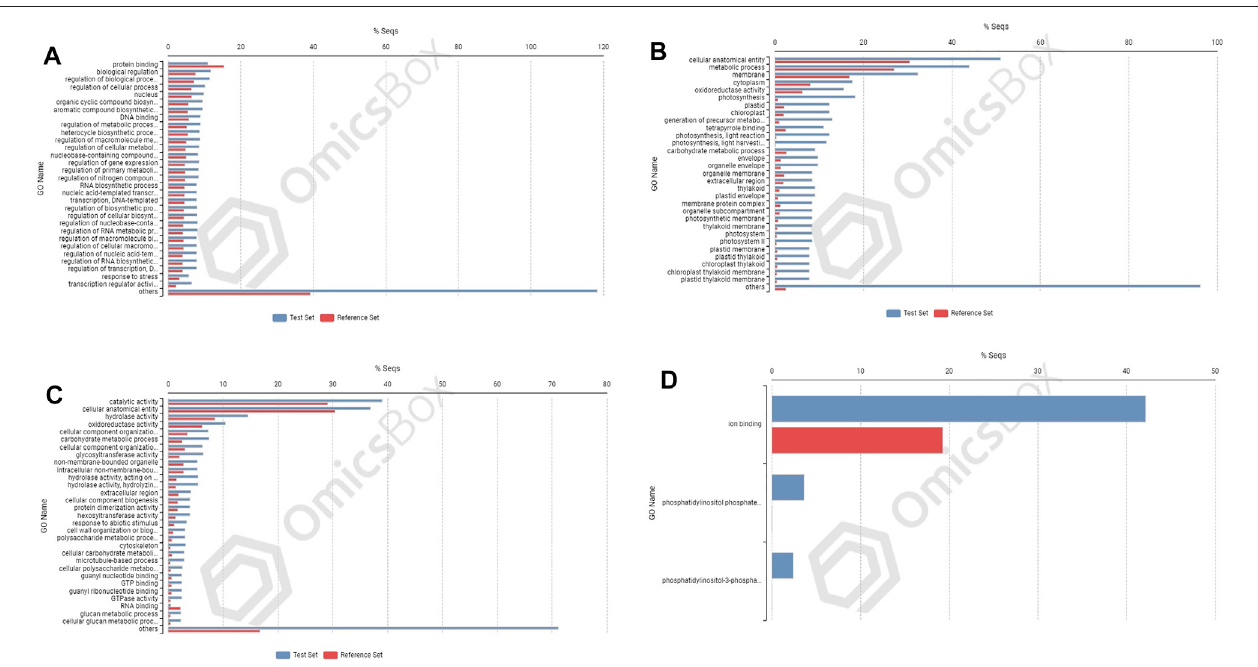
FIGURE6| EnrichmentanalysisshowinggenespresentinrootsofPBW677: (A) upregulatedand (B) downregulated;andinshoottissues: (C) upregulatedand (D) downregulated.